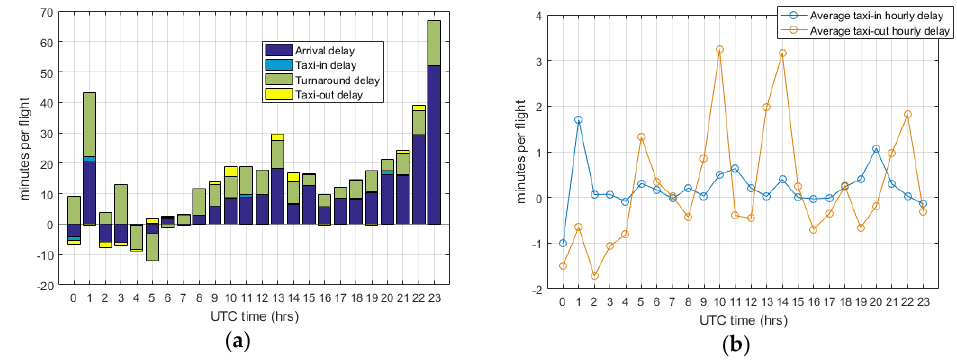
Figure 20. ( a ) Contribution of each stage to departure hourly average delay (min/operation), and ( b ) evolution of average taxiing hourly delay (min/operation) throughout the day.